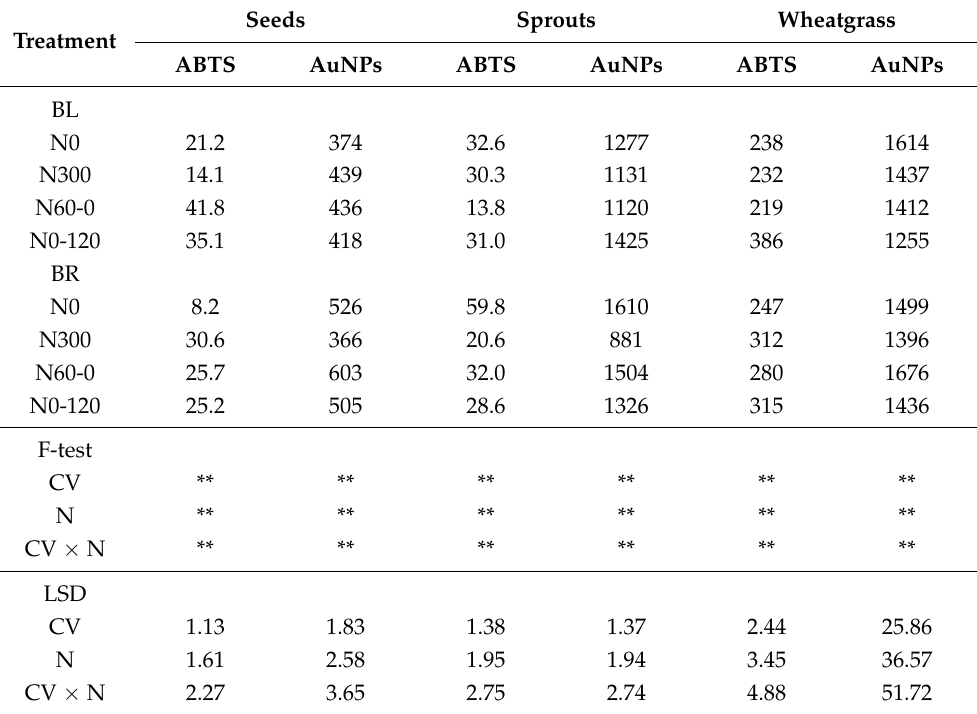
LSD CV 1.13 1.83 1.38 1.37 2.44 25.86 N 1.61 2.58 1.95 1.94 3.45 36.57 CV × N 2.27 3.65 2.75 2.74 4.88 51.72 Two-factor analysis of variance (ANOVA) at 5% level of probability: cultivar (CV); N fertilization schedules (N). ** p < 0.01; LSD = Least Significant Difference ( p < 0.05). The targeted analysis by LC-MS/MS allowed for characterizing the phenolic con- tent in the different matrices (Table 3). A set of 34 standard analytes was selected for the identification and quantification of phenolic compounds (PhCs), belonging to the class of phenolic acids or flavonoids, on the basis of the retention time (tR) and molec- ular weight (MW) of each analyte. On the basis of their phenolic content, three sets of samples (seeds, sprouts, and wheatgrass) were discriminated. In total, 19 compounds were identified belonging to the classes of phenylethanoids (hydroxytyrosol—OH-Tyr),